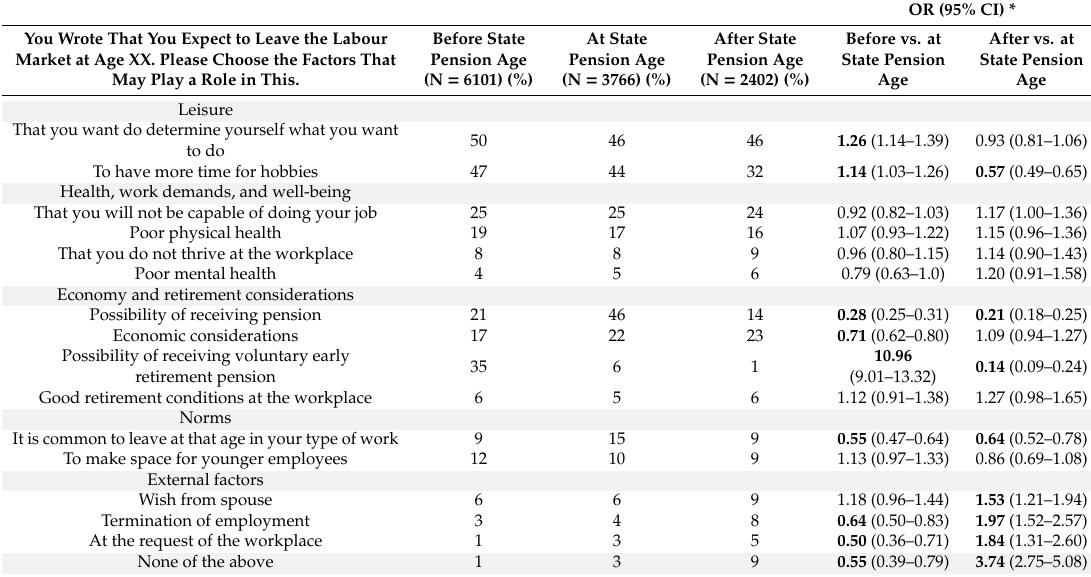
Table 2. Factors conditioning the retirement